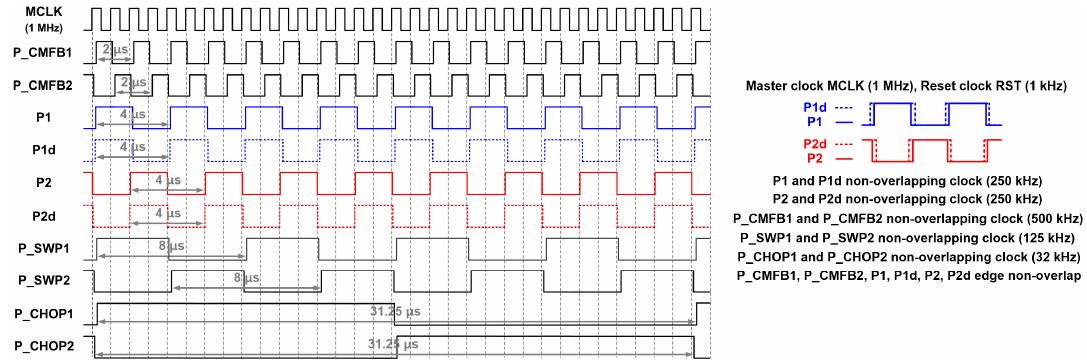
Figure 3. Timing diagram of the second-order delta-sigma CDC.